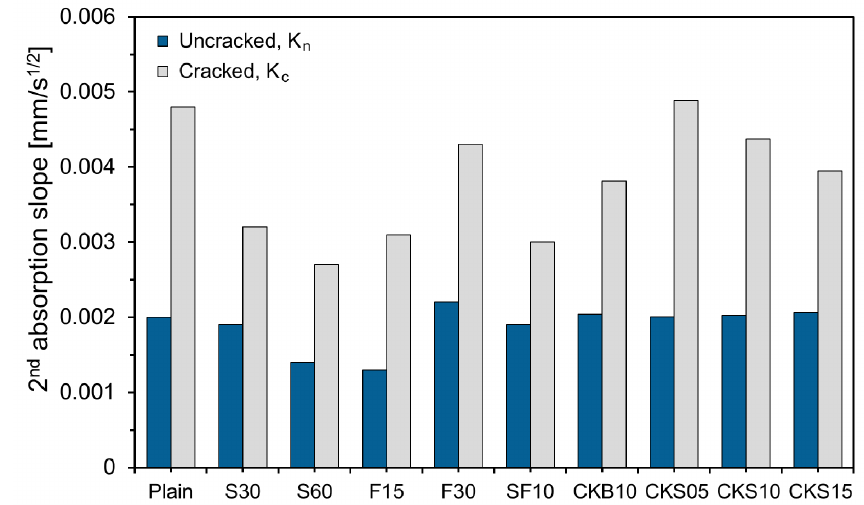
Figure 6. Second absorption slope of specimens.